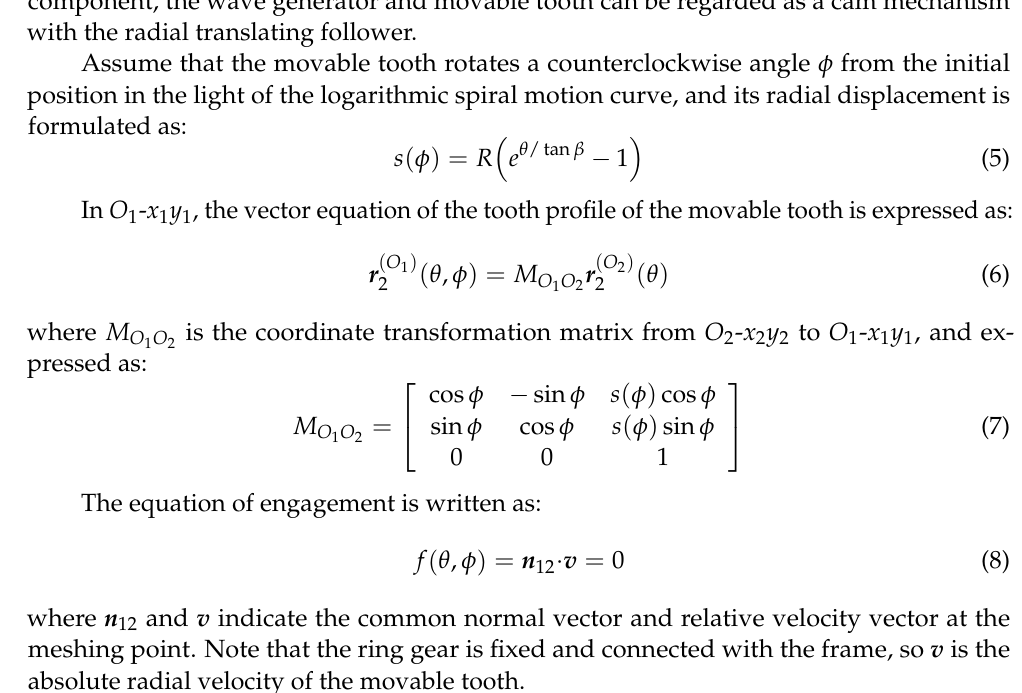
Figure 5. Envelope motion of the movable tooth.